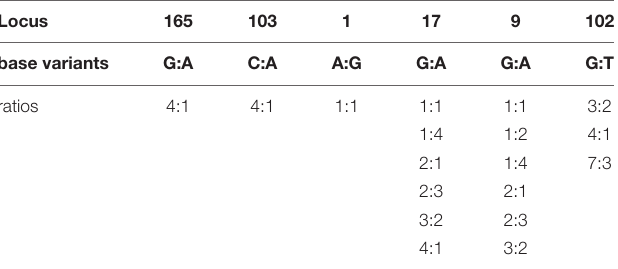
TABLE 4 | Combination patterns of AS-CNVs in the heterozygous samples at the six segregating sites in repeated fragments.* Locus